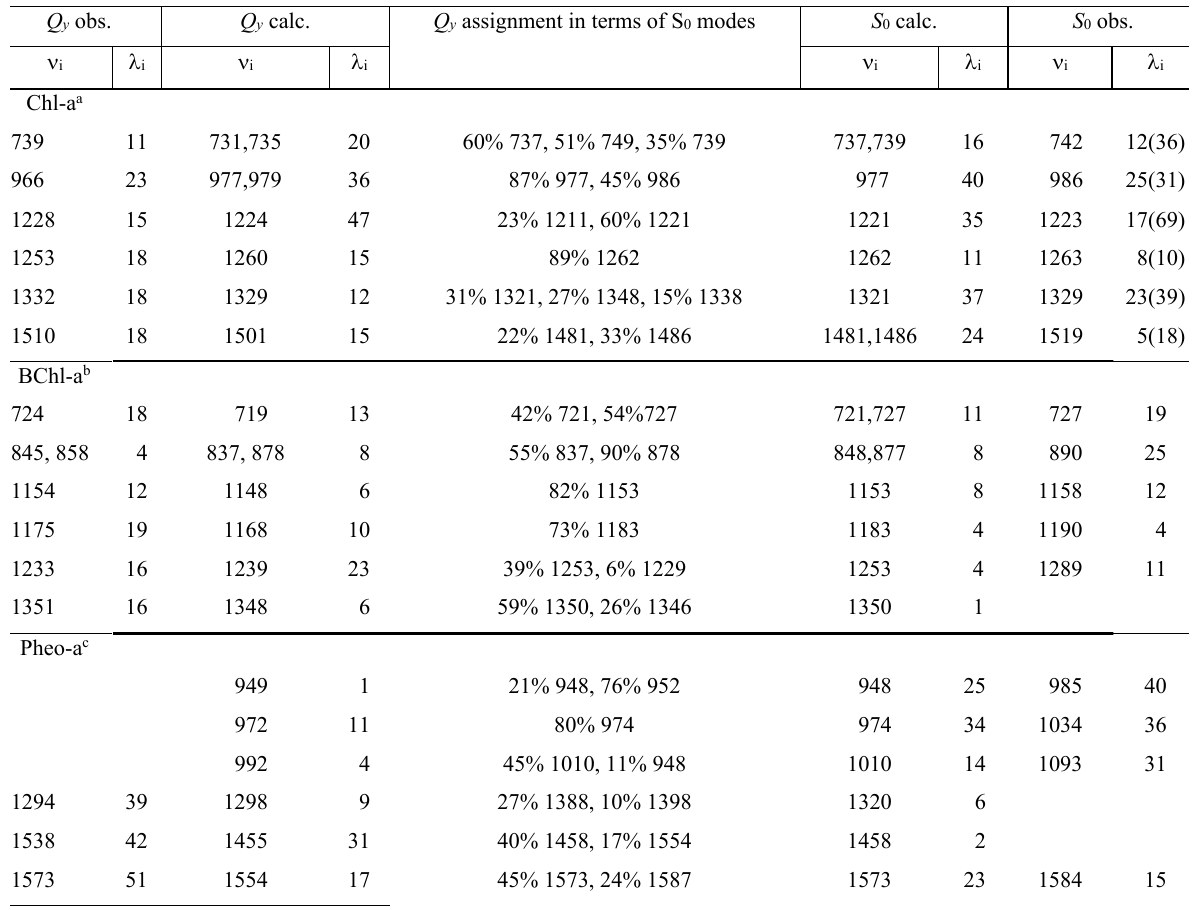
Table 2. Description of the lines observed at ~ 5 K in absorption ( Q Chl-a, BChl-a, and